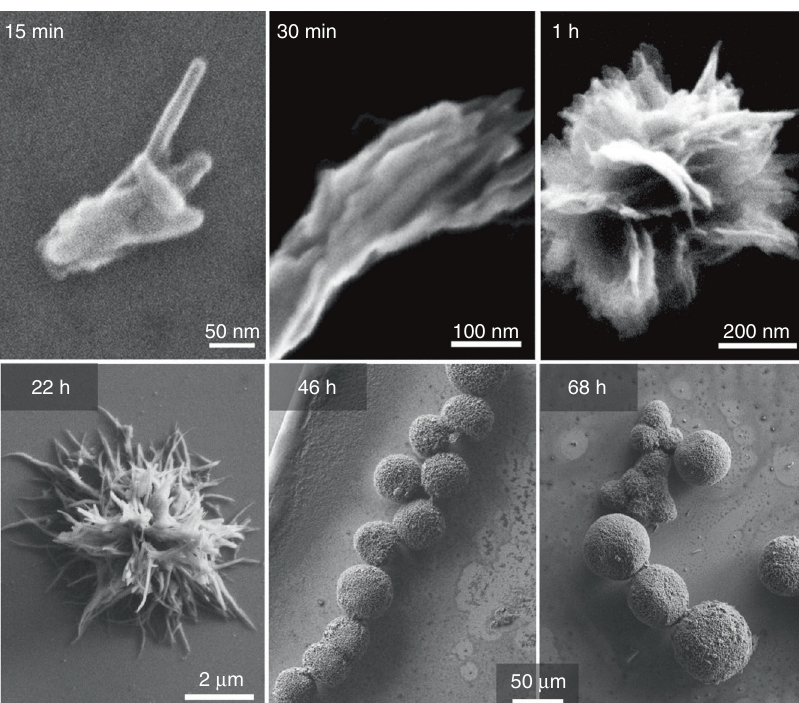
Fig. 2 SEM imaging of hierarchical crystal growth. Aliquots removed at different times during synthesis reveal the growth process of hierarchical crystals. Branching is occurring already at 15 min, and continues as the microstructures grow over 68 h. Monomeric quinacridone molecules precipitate onto exposed facets of the crystals, generating growth along this facet that progressively ceases to grow due to increased steric hindrance caused by attached alkylamine ligands. Repetition of this process maintains branched growth as the microstructures expand